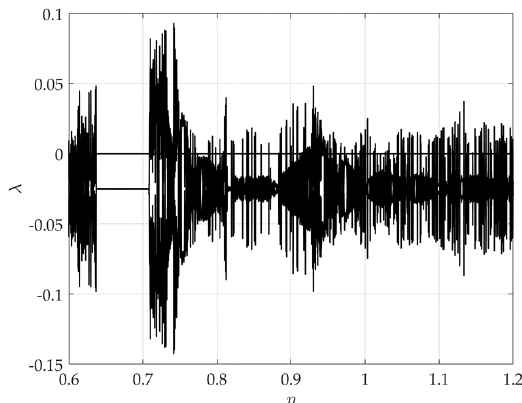
Figure 8. Lyapunov exponents for the impacted vibration system.